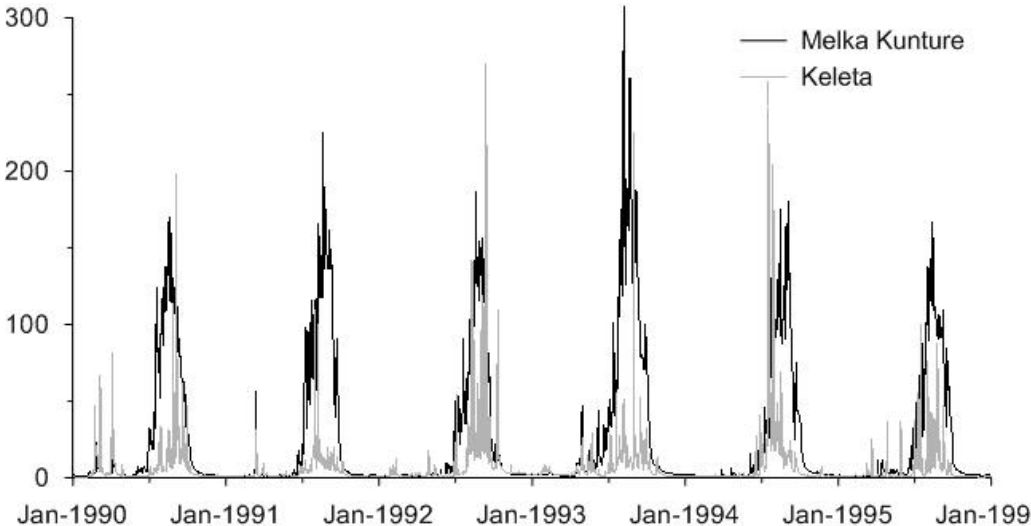
Figure 6. Observed streamflow (m 3 /s) at Melka Kunture and Keleta gauging stations (1990 – 1995).